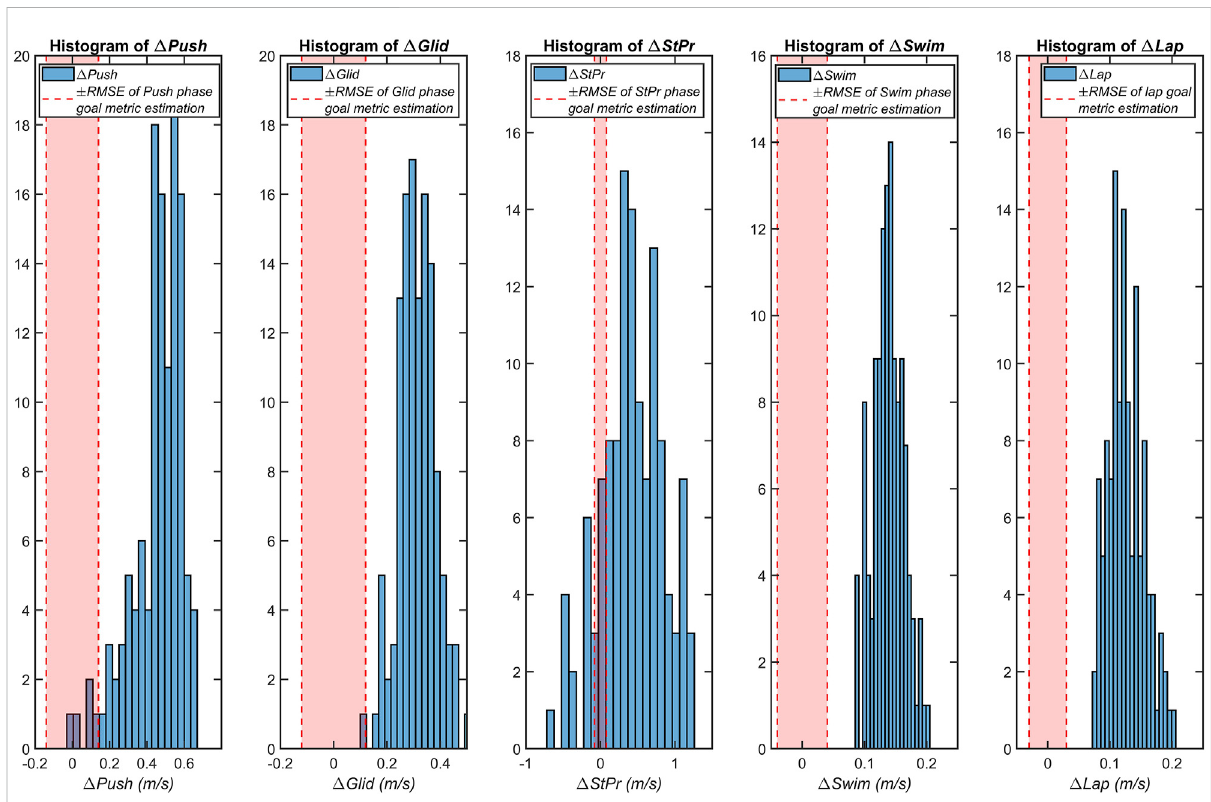
FIGURE 3 Histograms of changes in the fi ve IMU goal metrics ( Δ Push, Δ Glid, Δ StPr, Δ Swim, and Δ Lap ) for the comparisons with meaningful progress. The estimation RMSE range of each goal metric is displayed with red dashed lines.